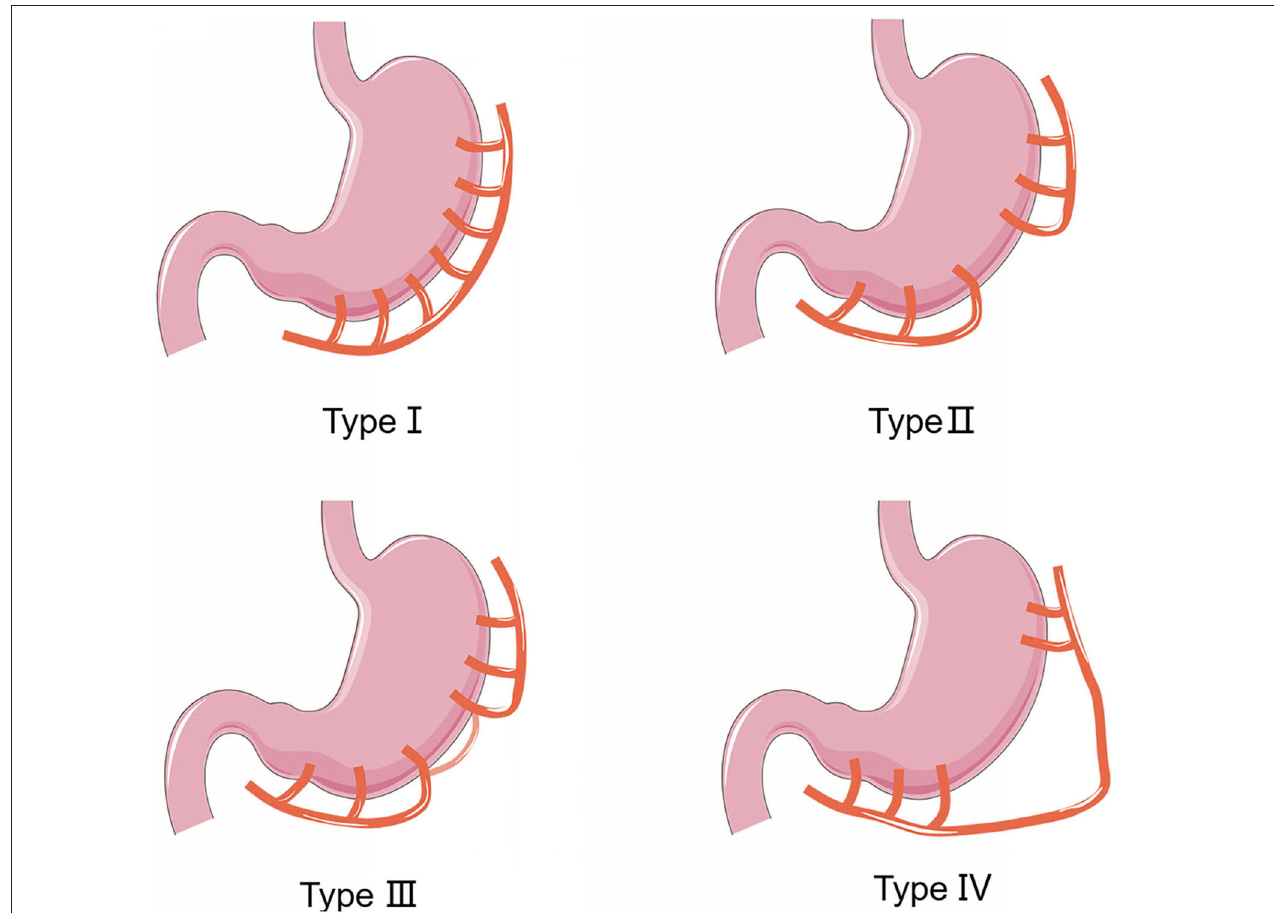
FIGURE 3 | Four types of anatomic variations of the right gastroepiploic